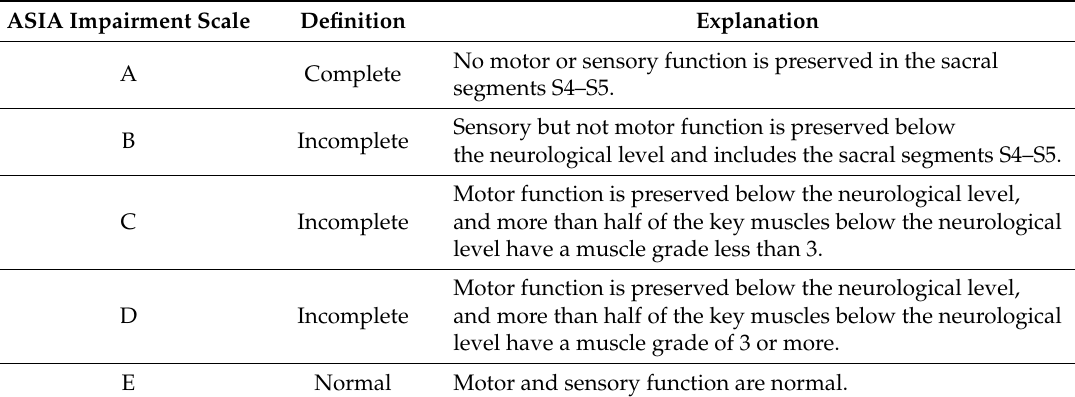
Table 1. The American Spinal Injury Association (ASIA) Impairment